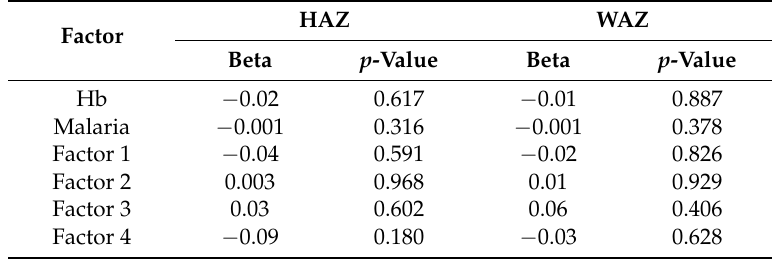
Table 6. HAZ and WAZ regressed on calculated factors (HAZ or WAZ = Factor + Hb + malaria). HAZ WAZ Factor Beta p -Value Beta p -Value Hb − 0.02 0.617 − 0.001 0.316 − 0.001